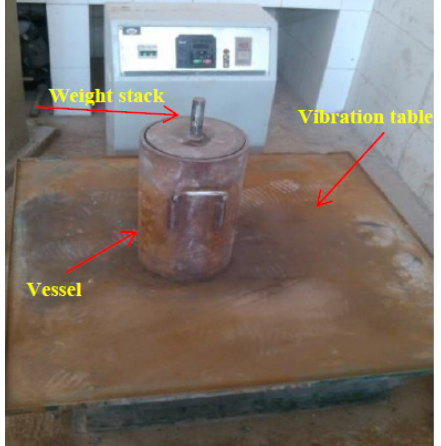
Figure 4. Vibrating compaction test device.